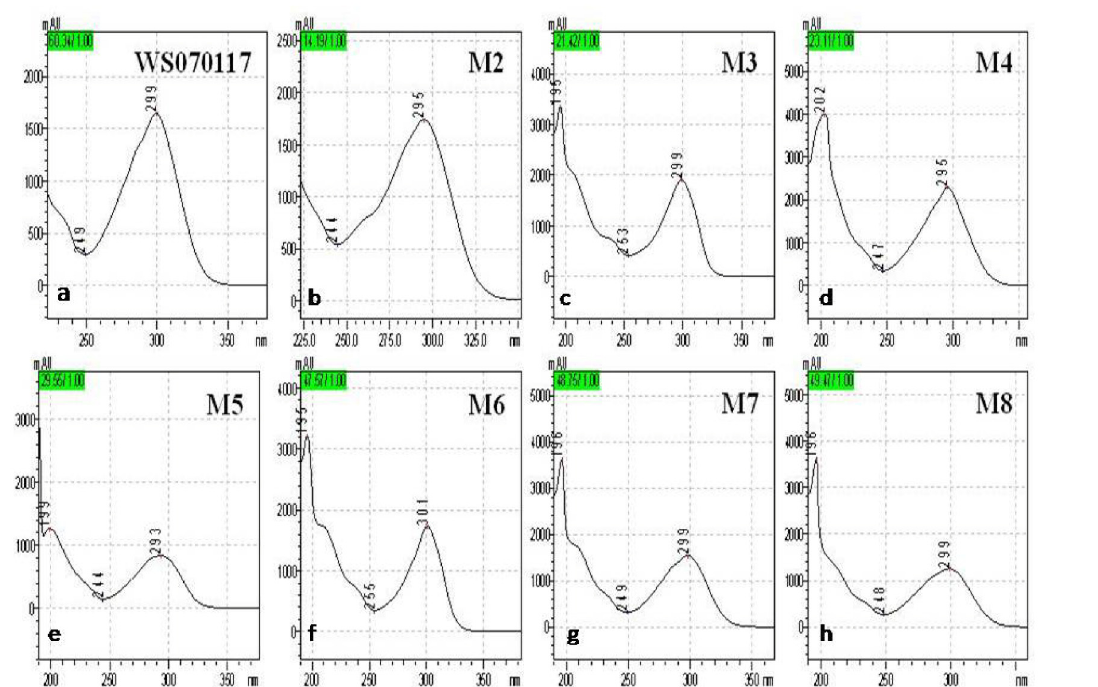
Fig 2. UV spectra of (a) WS070117; (b) M2; (c) M3; (d) M4; (e) M5; (f) M6; (g) M7; and (h) M8.